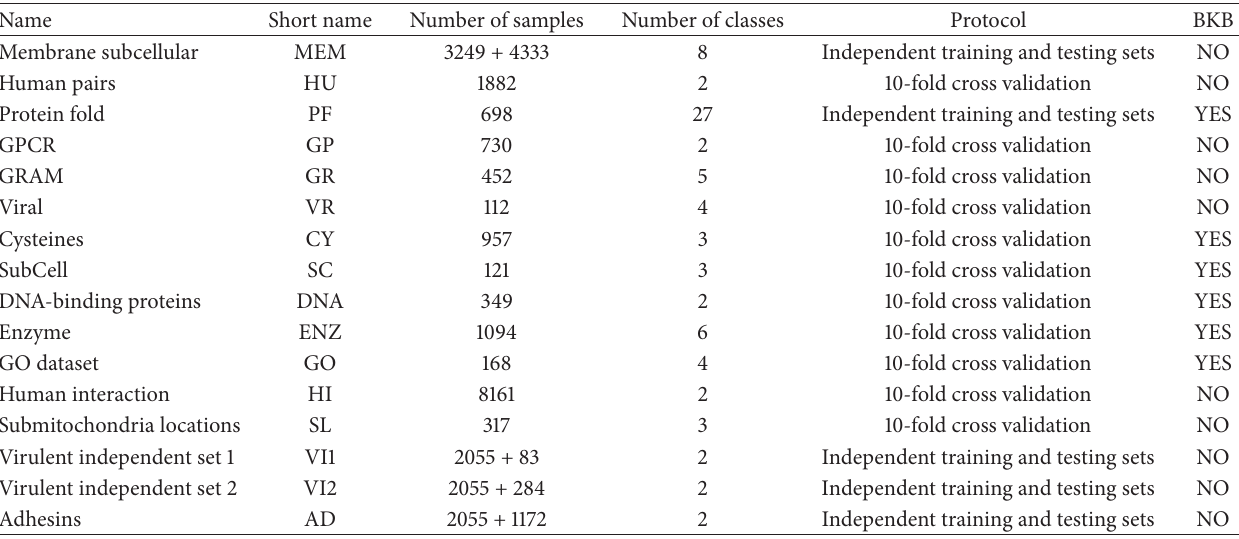
Table 1: Summarized description of the datasets (if available, the number of training and independent samples is given in column “number of samples”). The column BKB reports whether it is possible from the dataset to obtain the PDB of the proteins for extracting the backbone